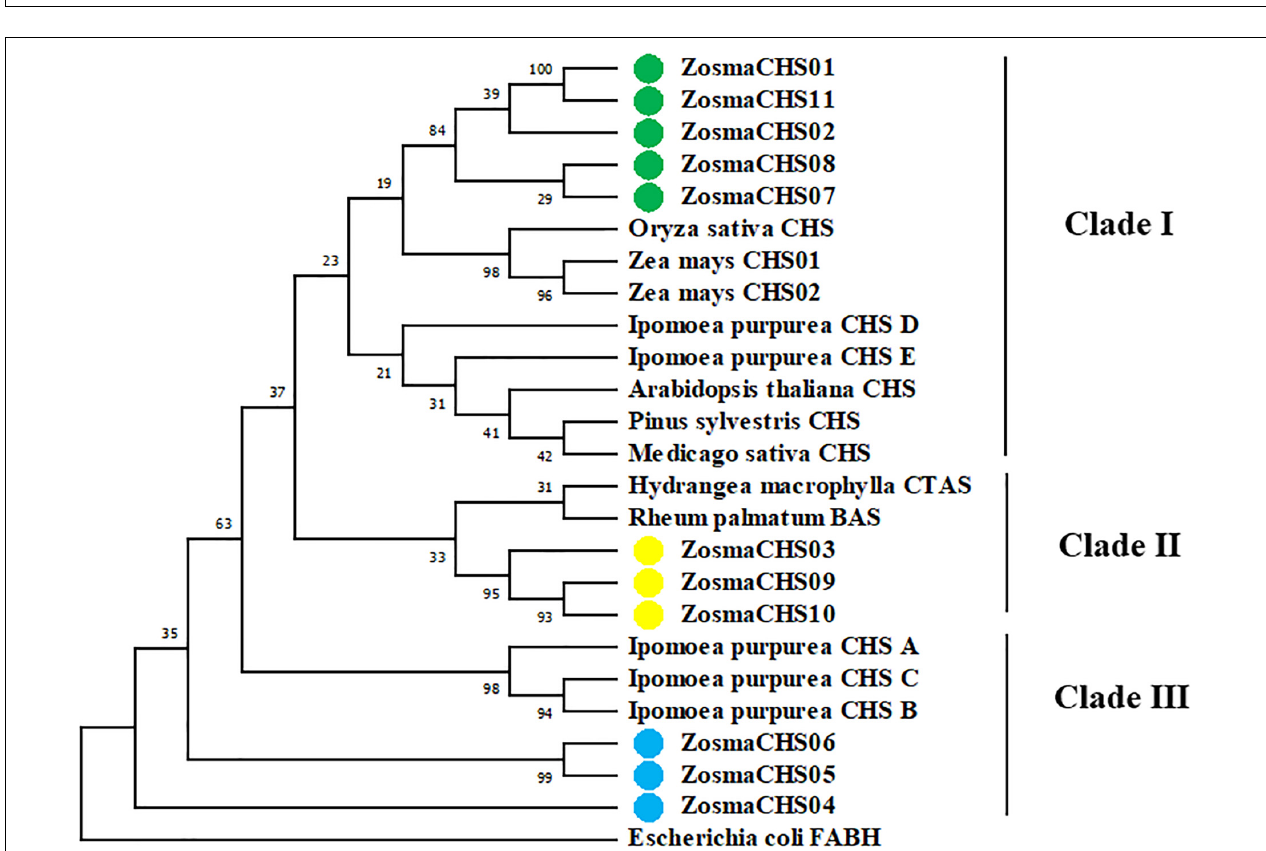
FIGURE 2 | Phylogenetic relationships of the ZosmaCHSs and CHS homologs from other plants using maximum likelihood method. Green, yellow and blue cycles indicate the ZosmaCHSs in clade I, II, and III, respectively.